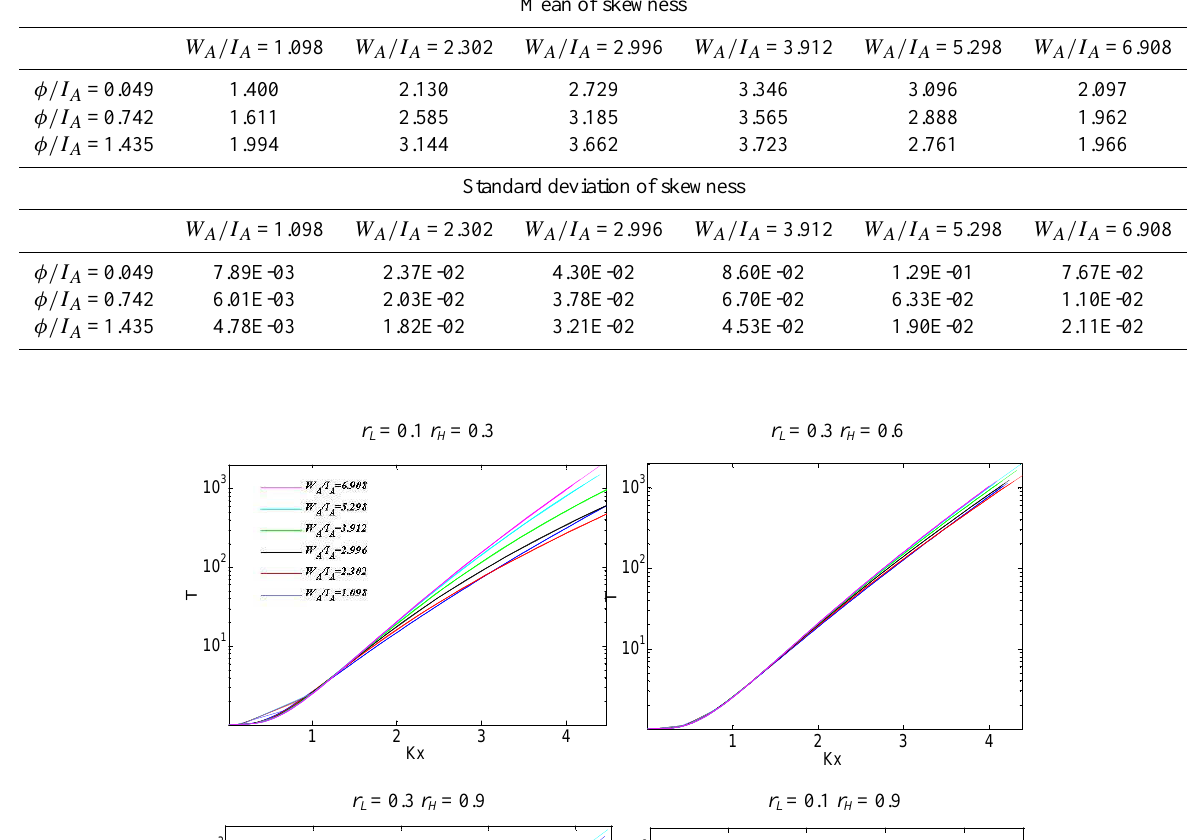
mean coefficient of skewness ranges from 1.595 to 3.417. In Table 7, for r L = 0.3, r H = 0.6 the mean coefficient of skew- ness ranges from 1.540 to 1.826, which is the minimum peak of skewness observed over all the parameter sets. In Table 8, for r L = 0.3, r H = 0.9, we observe the minimum coefficient of skewness equal to 1.472 and a peak of skewness of 1.935. In Table 9, for r L = 0.1, r H = 0.9 we have the minimum coeffi- cient of skewness of 1.400 and a peak of skewness of